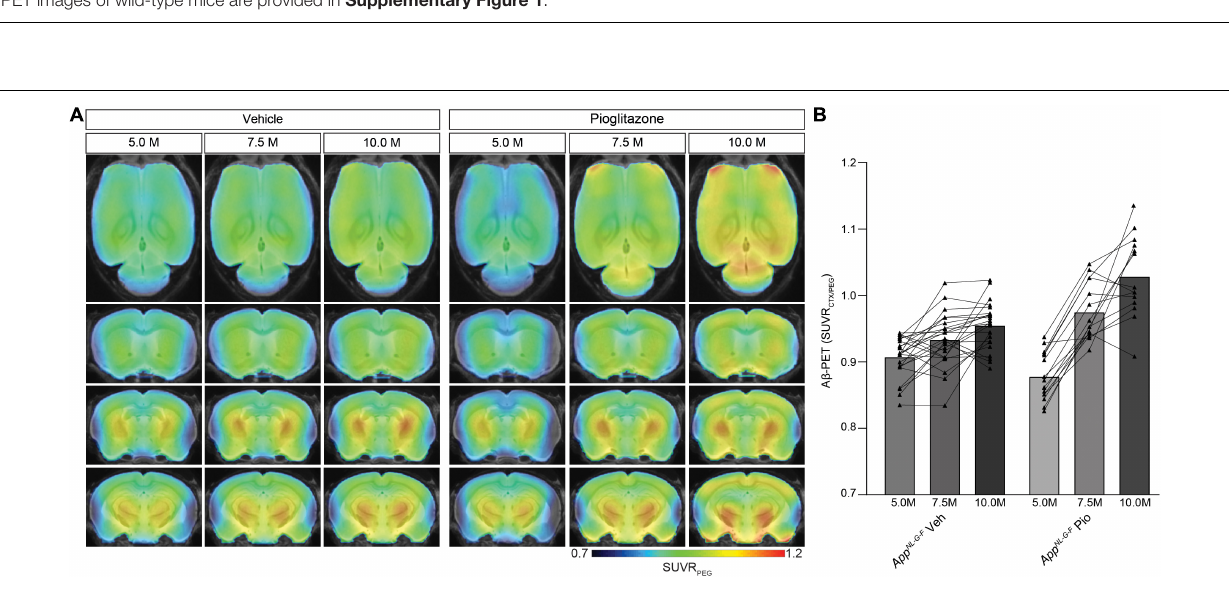
Frontiers in Aging Neuroscience |